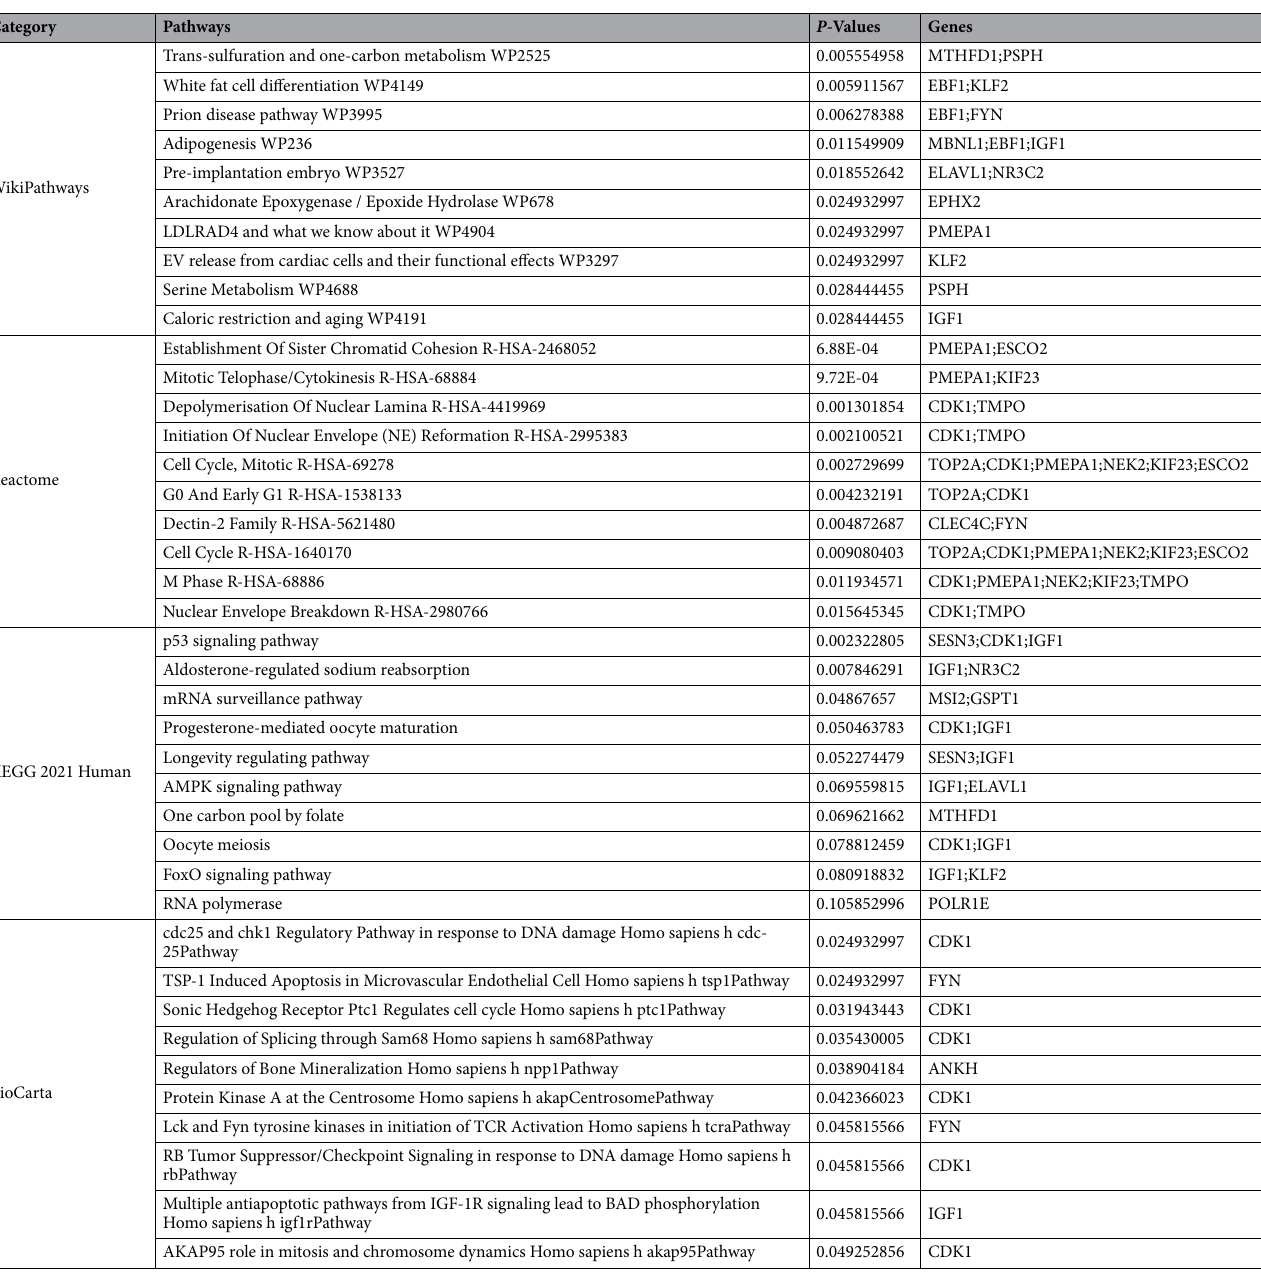
Table 3. Pathway enrichment analysis of shared DEGs between EBV, SLE, and